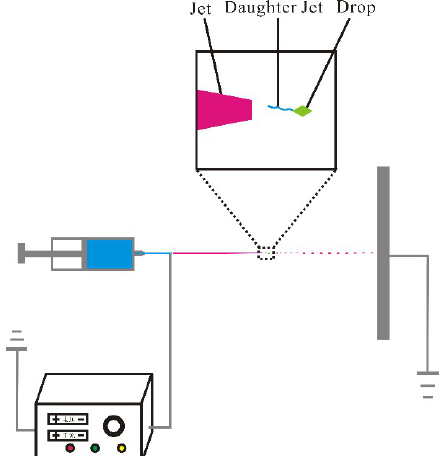
Figure 5. Dropping in a moving jet in electrospinning.